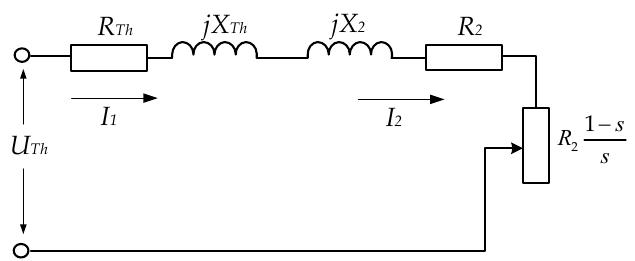
Figure 3. Thevenin equivalent circuit of AC induction motor. U Th , R Th , and X Th are the equivalent Thevenin input voltage, resistance, and reactance of the stator winding.